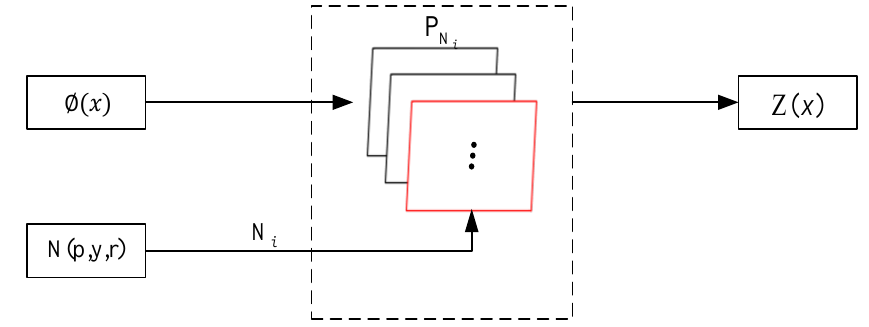
Figure 3. Schematic diagram of the transformation layer.